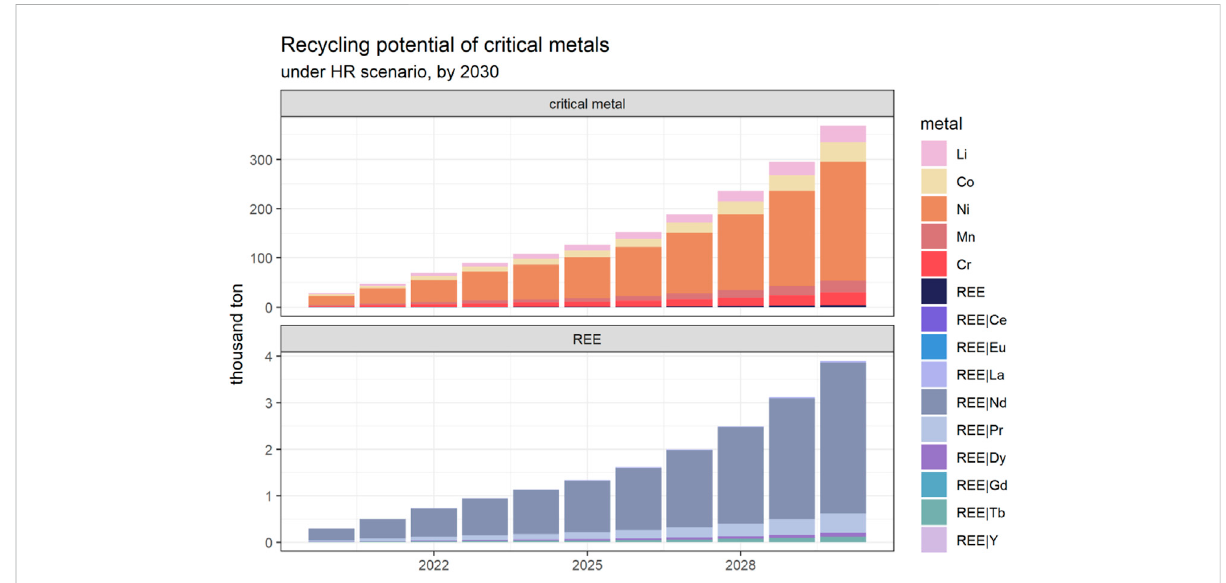
FIGURE 7 RecyclingpotentialofcriticalmetalsunderHRscenariofrom2020to2030inChina(thousandtons):totalmetalrecyclingandthedetailsinREE. The recycling potential of critical metals in EOL EVa is increasing year by year. HR scenario results based on Li et al. (2021).